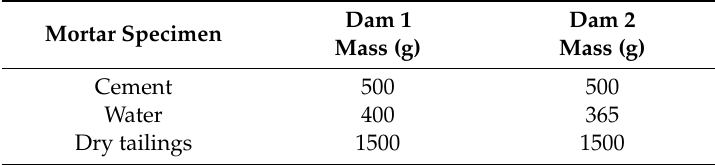
Table 2. Cement, tailings, and water dosage for making reference specimens using materials from Dams 1 and